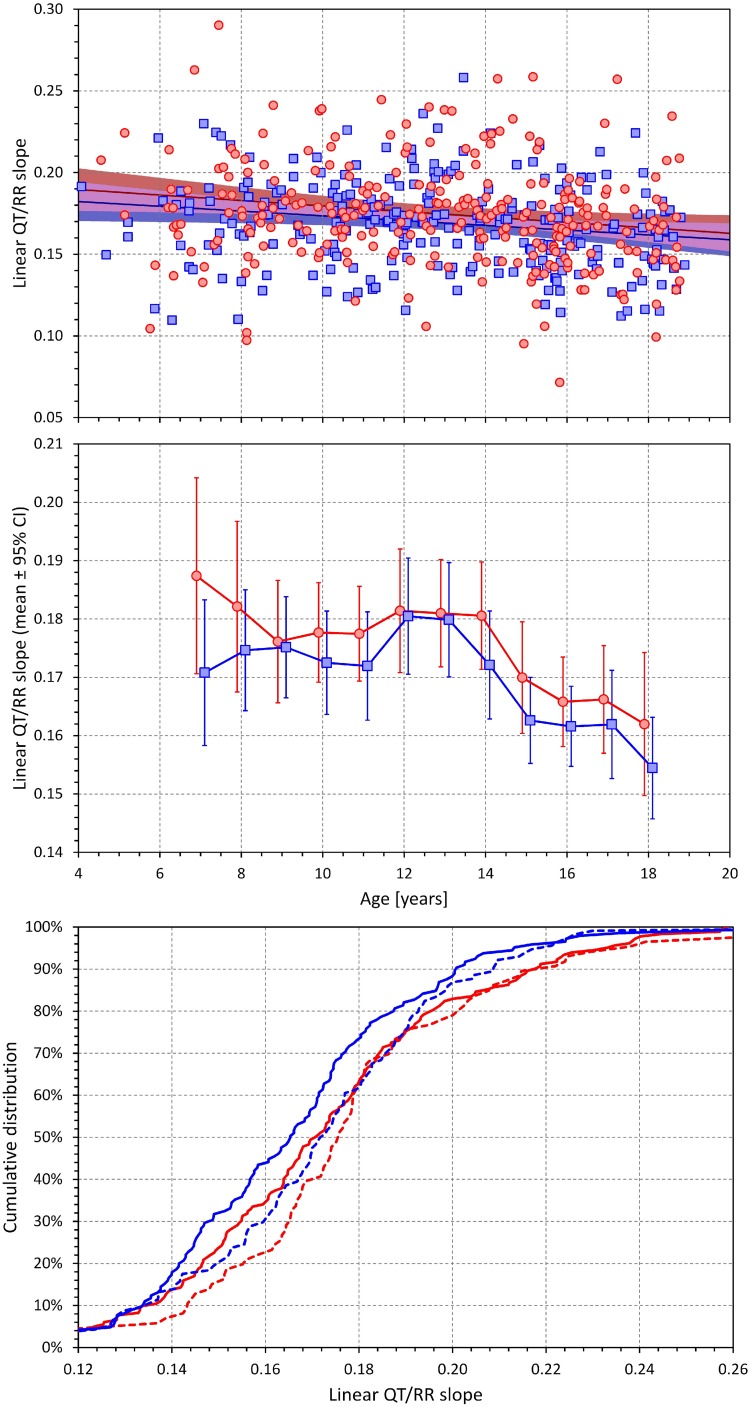
Development of the age dependency of linear QT/RR slopes in both sexes. The layout and meaning of the three panels are the same as the layout and meaning of the three panels of Figure 6.